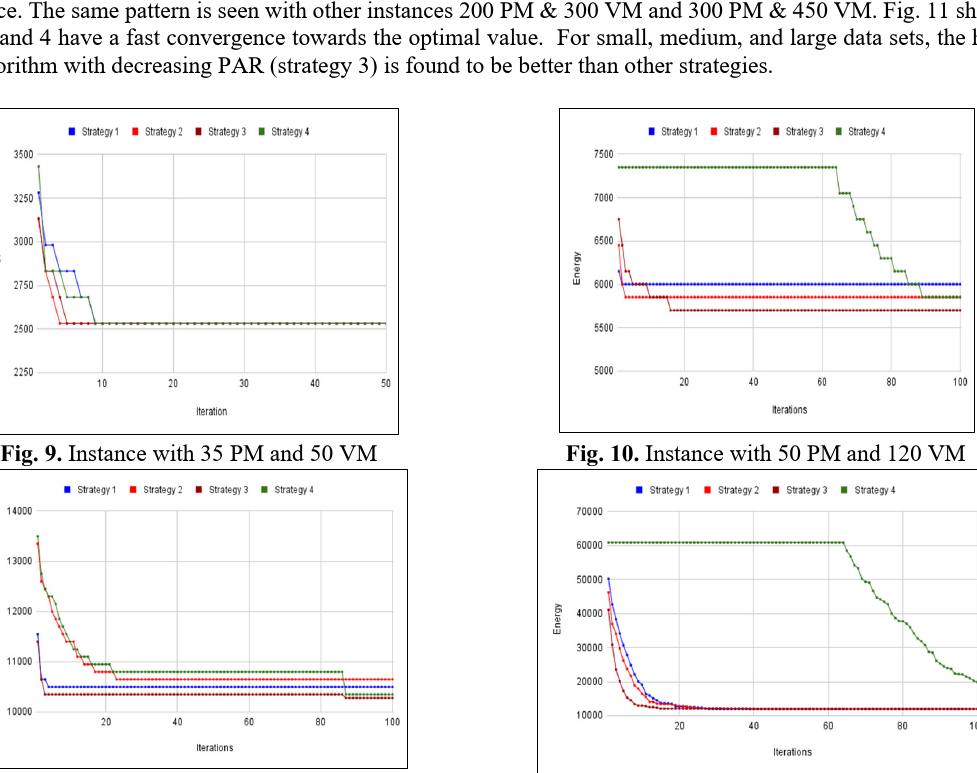
Fig. 9. Instance with 35 PM and 50 VM Fig. 10. Instance with 50 PM and 120 VM